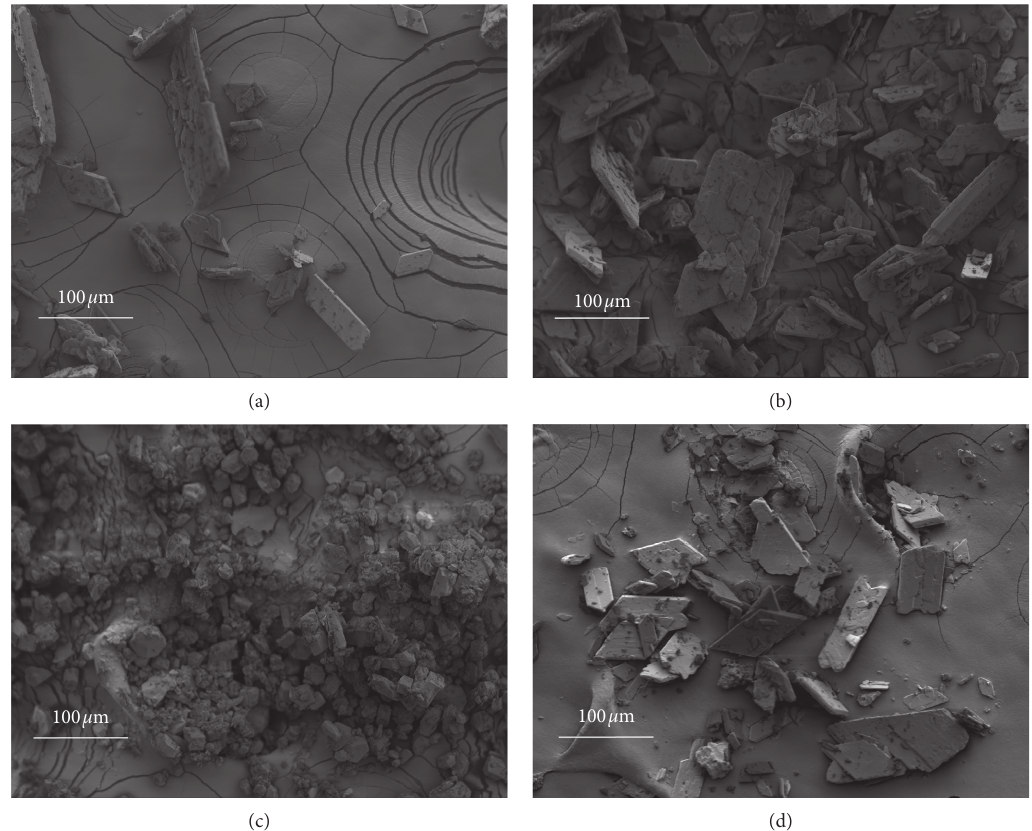
Figure 12: SEM images of solid-phase crystals obtained under different reaction times in the presence of 0.02% succinic acid: (a) 0.5 h; (b) 1h; (c) 1.5 h; and (d)